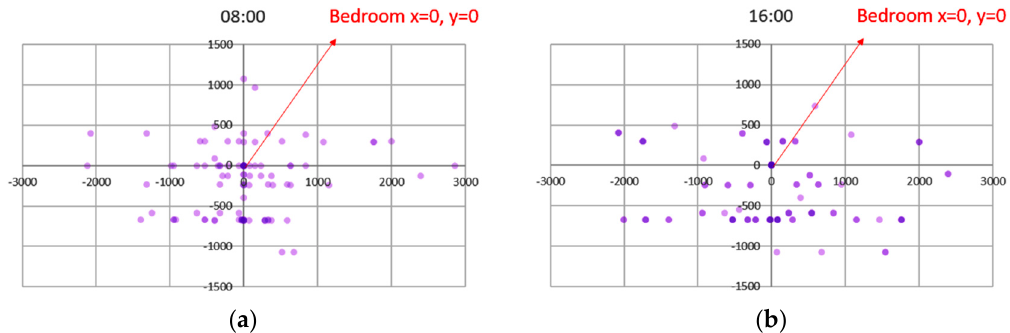
Figure 6. Resident and bedroom relationships. The collective movement patterns show that residents stayed around the bedrooms at 8 a.m. and moved farthest away from the bedroom around 4 p.m: ( a ) at 8 a.m., most residents were located within 5–10 m from their bedrooms; ( b ) at 4 p.m., some residents expanded their mobility range to between 10–20 m.